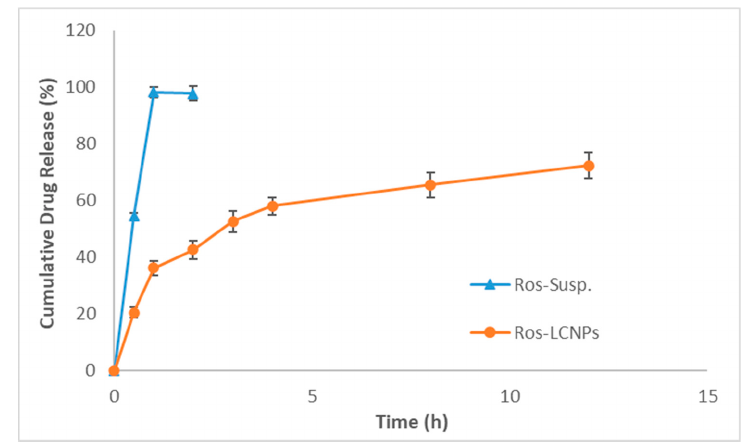
Figure 4. Release profile of Ros-LCNPs compared with ROS suspension (Ros-Susp).